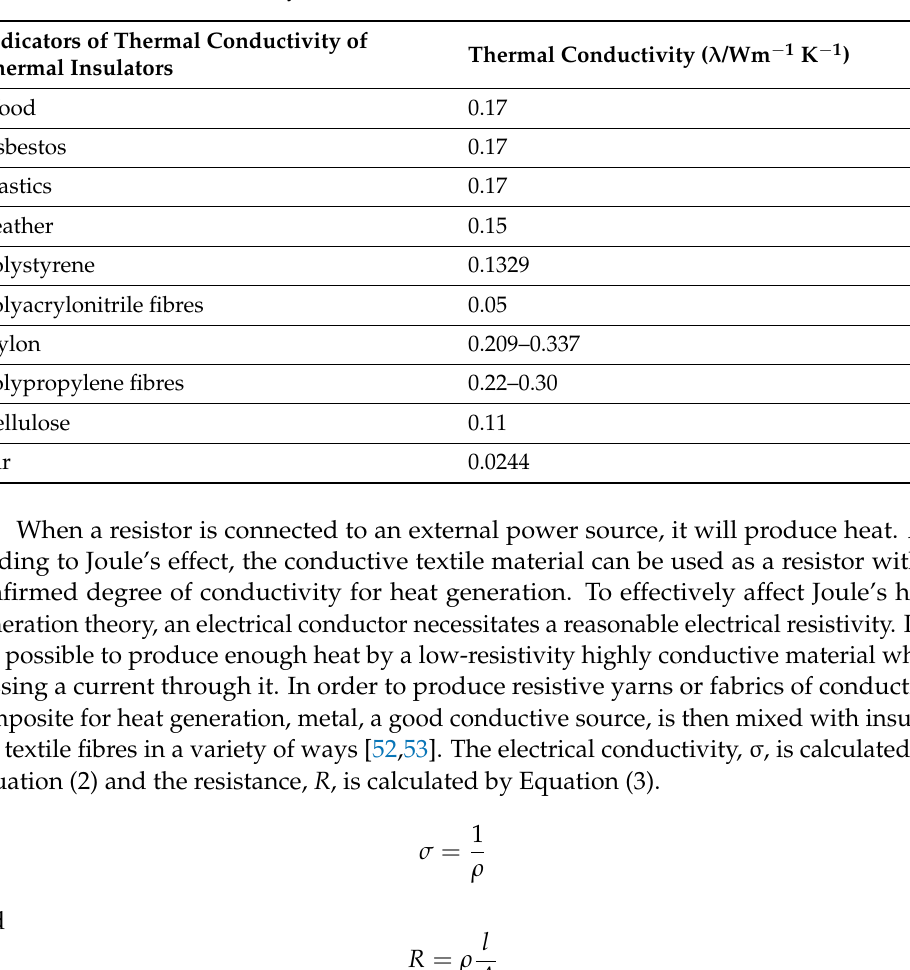
Table 2. The thermal conductivity of several materials